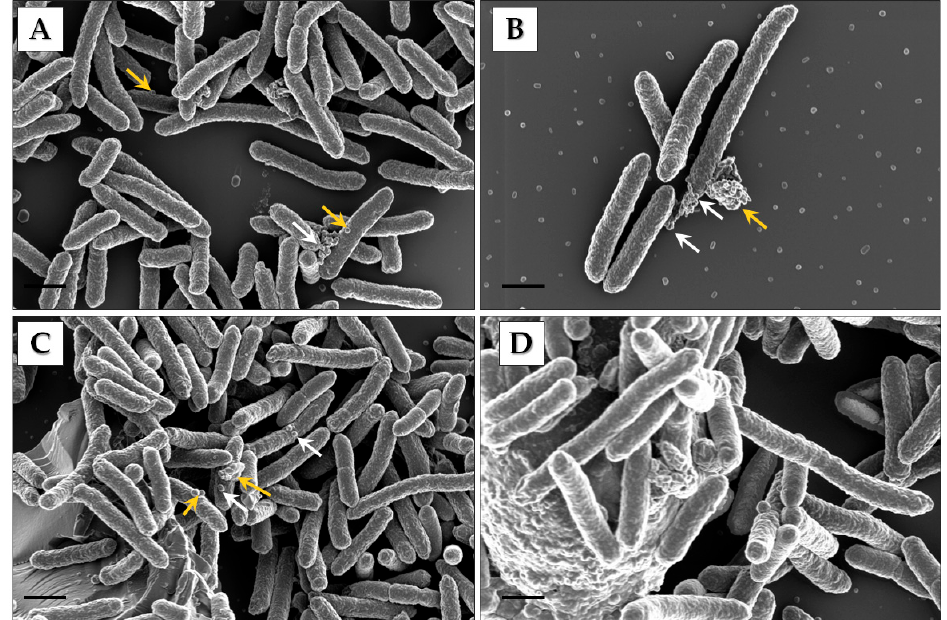
Figure 1. Identification of OMVs produced by Pbr1692. ( A , B ) In the SEM images, gold arrows indi- cate OMVs of cells and OMV aggregates in the exponential growth phase. The white arrows show vesiculation “hot spots”. ( C ) The image of cells in stationary growth shows OMVs at the surface of the bacteria indicated by white arrows. Gold arrows indicate OMV aggregates and “hot spots.” ( D ) The image shows OMVs embedded in the biofilm matrix-like backbone. Scale bars = 1 µm.